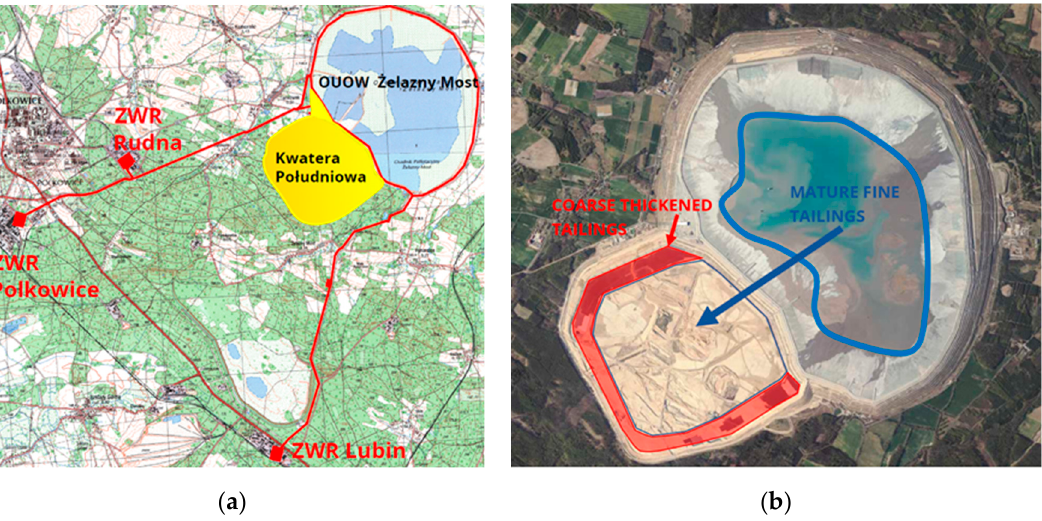
Figure 1. ( a ) Hydrotransport network map; ( b ) satellite image of TSF Ż elazny Most (geoportal).